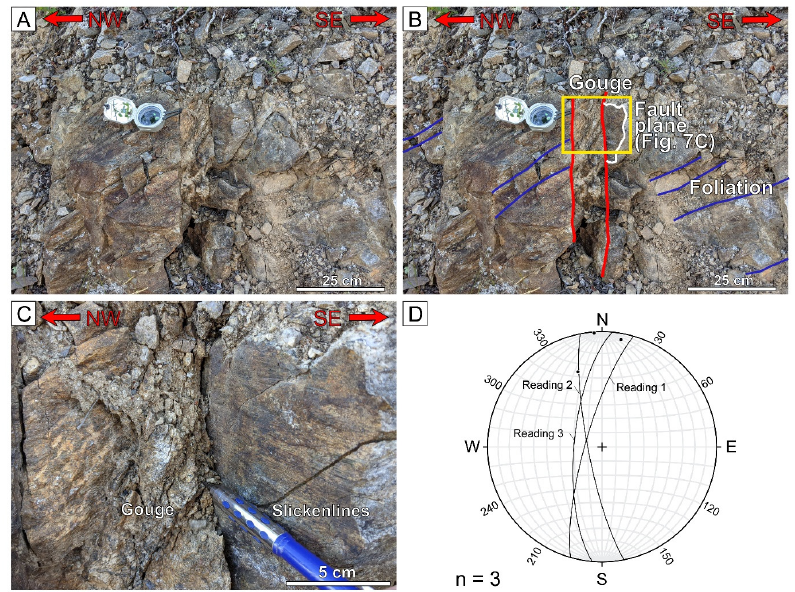
dipping strike-slip fault was observed to be cutting through schists belonging to DMF3 (Figure 7, Table 1; star labeled ‘Figure 7’ in Figure 2).